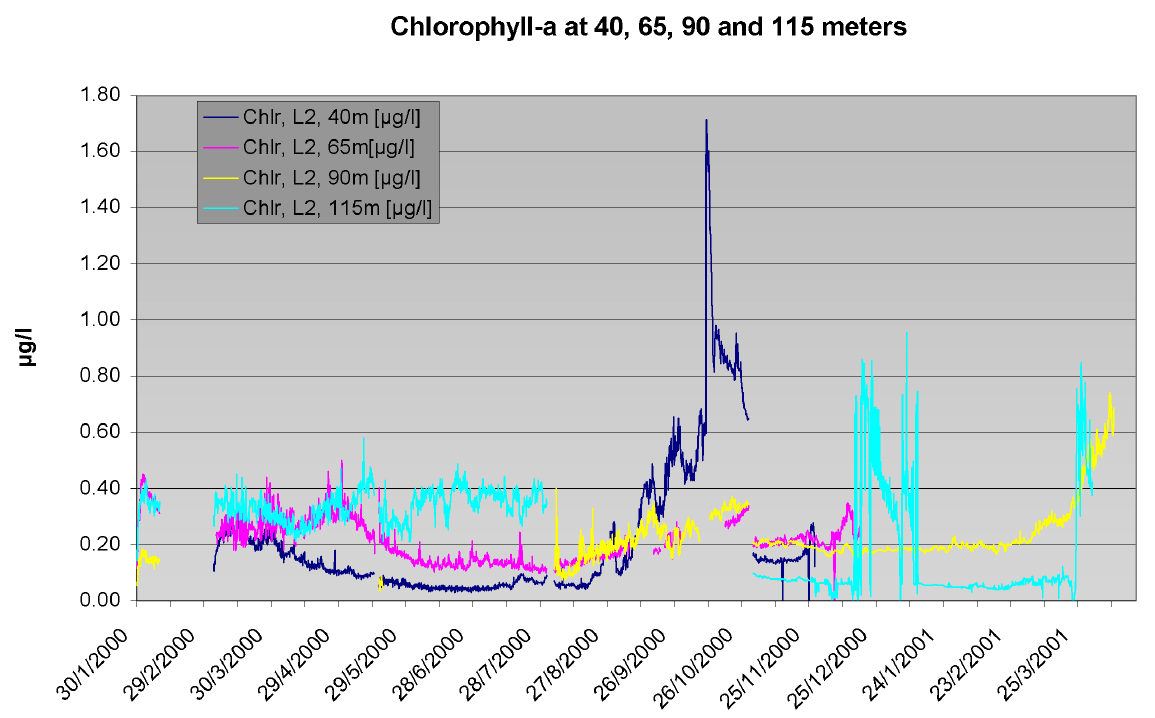
Fig. 10. Time series of chlorophyll-a at 40, 65, 90 and 115m